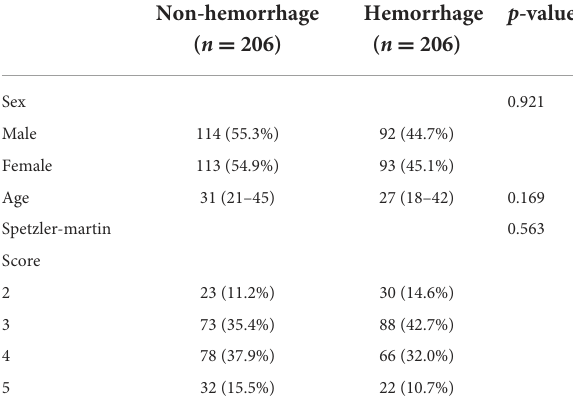
TABLE 1 The baseline information after preference score matching. TABLE 2 The results of univariate